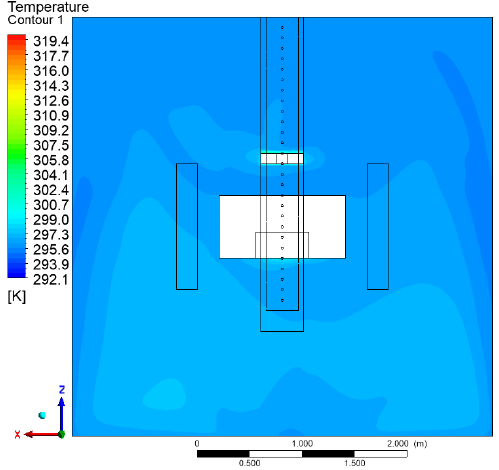
Figure 9. The temperature distribution of the Z = 2 m section.